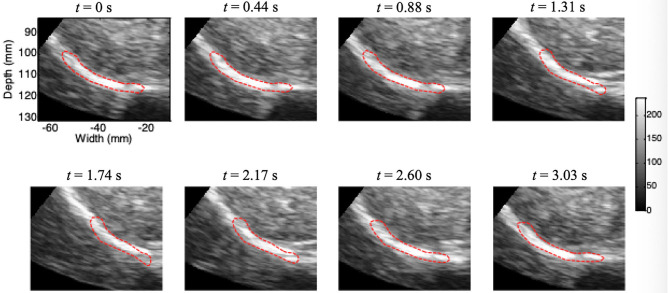
Movement of the diaphragm tracked during one breathing cycle based on the Interp_Both algorithm (red circle, ROI).